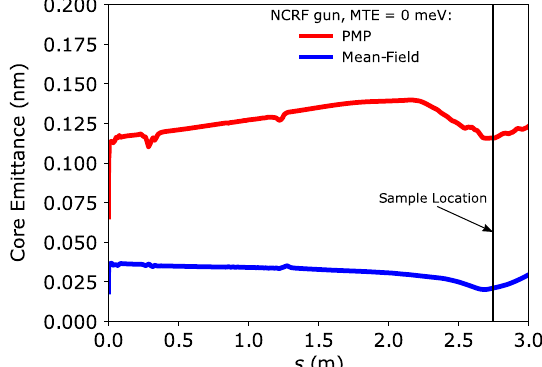
FIG. 9. Core emittance comparison between PMP and mean- field space charge for the NCRF UED beam line with 0 MTE.